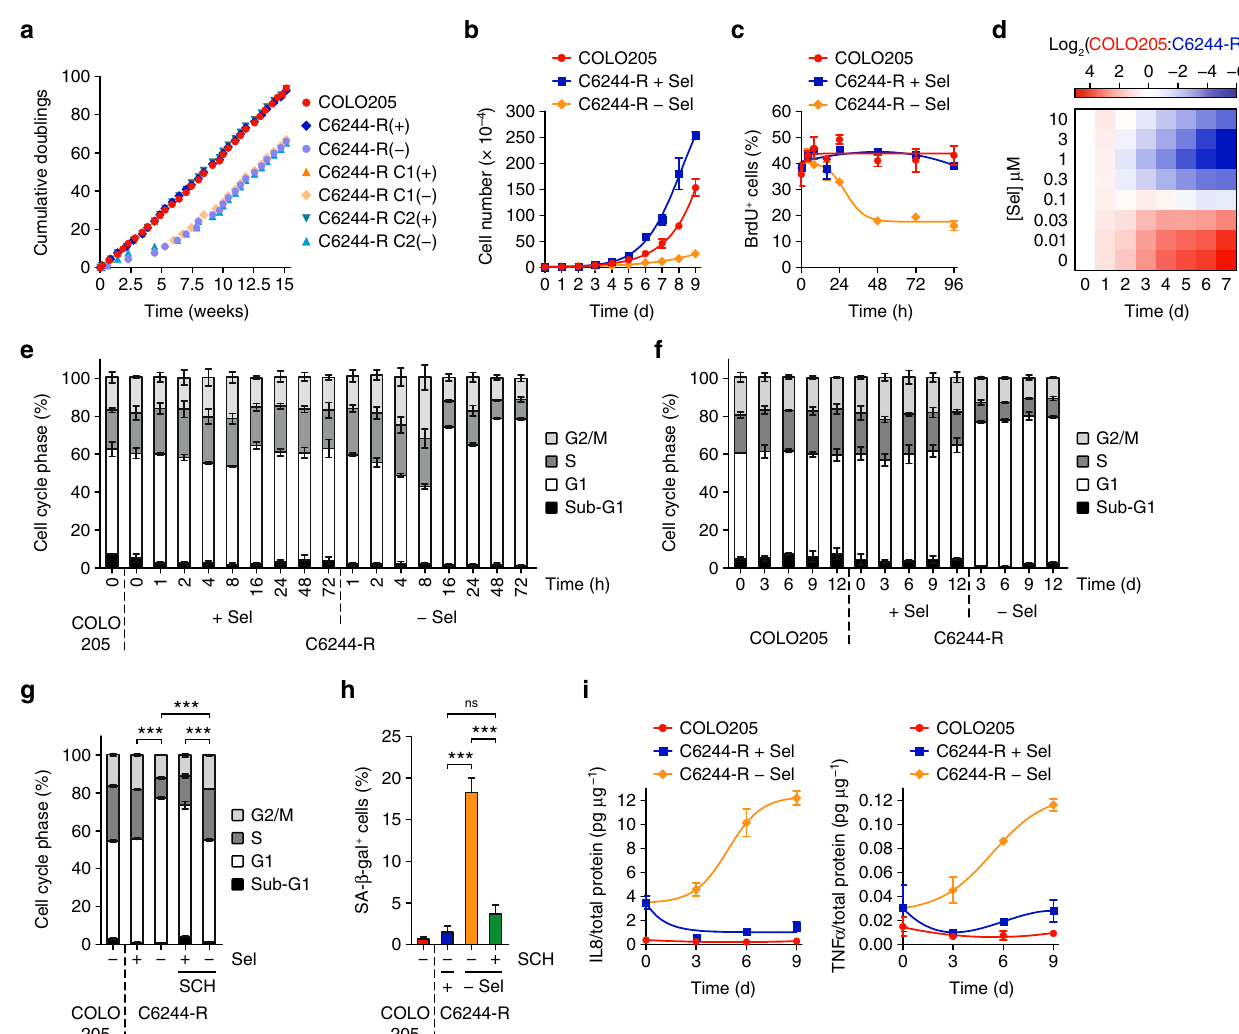
Fig. 2 MEKi withdrawal from BRAF V600E -ampli fi ed MEKi-resistant COLO205 cells causes cell cycle arrest and senescence. a Cumulative doubling tallies for cells growing in the presence ( + ) or absence (COLO205 and ( − )) of selumetinib over 15 weeks. b COLO205 and C6244-R cells were treated with 1 μ M selumetinib (C6244-R + Sel) or DMSO only (COLO205, C6244-R − Sel) and cell numbers counted over 9 days. Results are mean ± SD of cell culture triplicates, representative of two experiments. c COLO205 and C6244-R cells were washed and treated with 1 μ M selumetinib (C6244-R + Sel) or DMSO only (COLO205, C6244-R − Sel) and bromodeoxyuridine (BrdU) incorporation assayed at the indicated time points using fl ow cytometry. d COLO205 and C6244-R cells were independently labelled with distinct cell membrane dyes, mixed 1:1 and treated as indicated with selumetinib for 7 days. COLO205: C6244-R cell number ratio was determined daily by fl ow cytometry. Results are log 2 (mean COLO205:C6244-R cell number ratio) of four independent experiments. e , f COLO205 and C6244-R cells were treated with either 1 μ M selumetinib (C6244-R + Sel) or DMSO only (COLO205, C6244-R − Sel) for the indicated times, and cell cycle distribution determined by fl ow cytometry. g COLO205 or C6244-R cells were treated with 1 μ M selumetinib (Sel; + ) or DMSO only ( − ), with or without 30 nM SCH772984 (SCH) for 72 h, and cell cycle distribution determined by fl ow cytometry. h COLO205 and C6244-R cells were treated with 1 μ M selumetinib (C6244-R + Sel) or DMSO only (COLO205, C6244-R − Sel) for 9 days, after which the number of senescence- associated β -galactosidase-positive (SA- β -gal + ) cells was scored. i C6244-R cells were treated with 1 μ M selumetinib (C6244-R + Sel) or DMSO only (C6244-R − Sel) for up to 9 days, after which IL8 (left) or TNF α (right) levels in the culture medium were determined by ELISA. IL8 and TNF α levels were normalized to total cellular protein. c – i Results are mean of at least three ( c – h ) or two ( i ) independent experiments and error bars indicate SD. P < 0.001 (***) or P > 0.05 (ns) determined by one-way ANOVA with Tukey ’ s multiple comparisons test of G1 fractions ( g ) or SA- β -gal-positive cells ( h